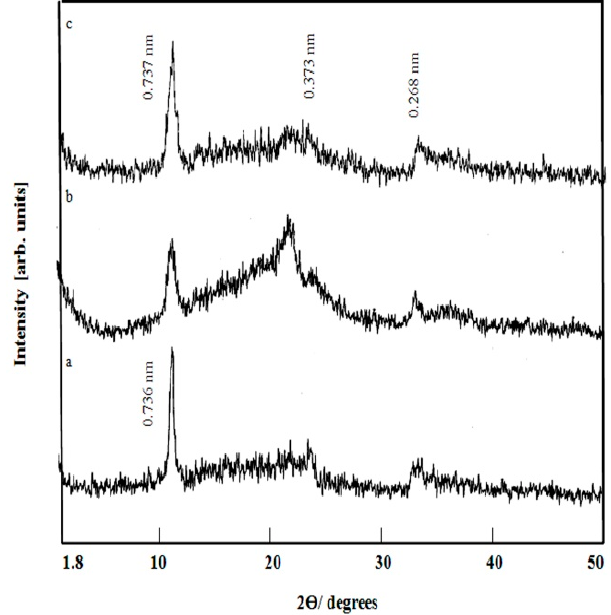
ff raction of ( a ) Ni-Ti-5 LDHs, ( b ) Ni-Ti-4 LDHs and ( c ) Ni-Ti-3 Figure 3. X-ray diffraction of ( a ) Ni-Ti-5 LDHs, ( b ) Ni-Ti-4 LDHs and ( c ) Ni-Ti-3 LDHs. Figure 3. X-ray di